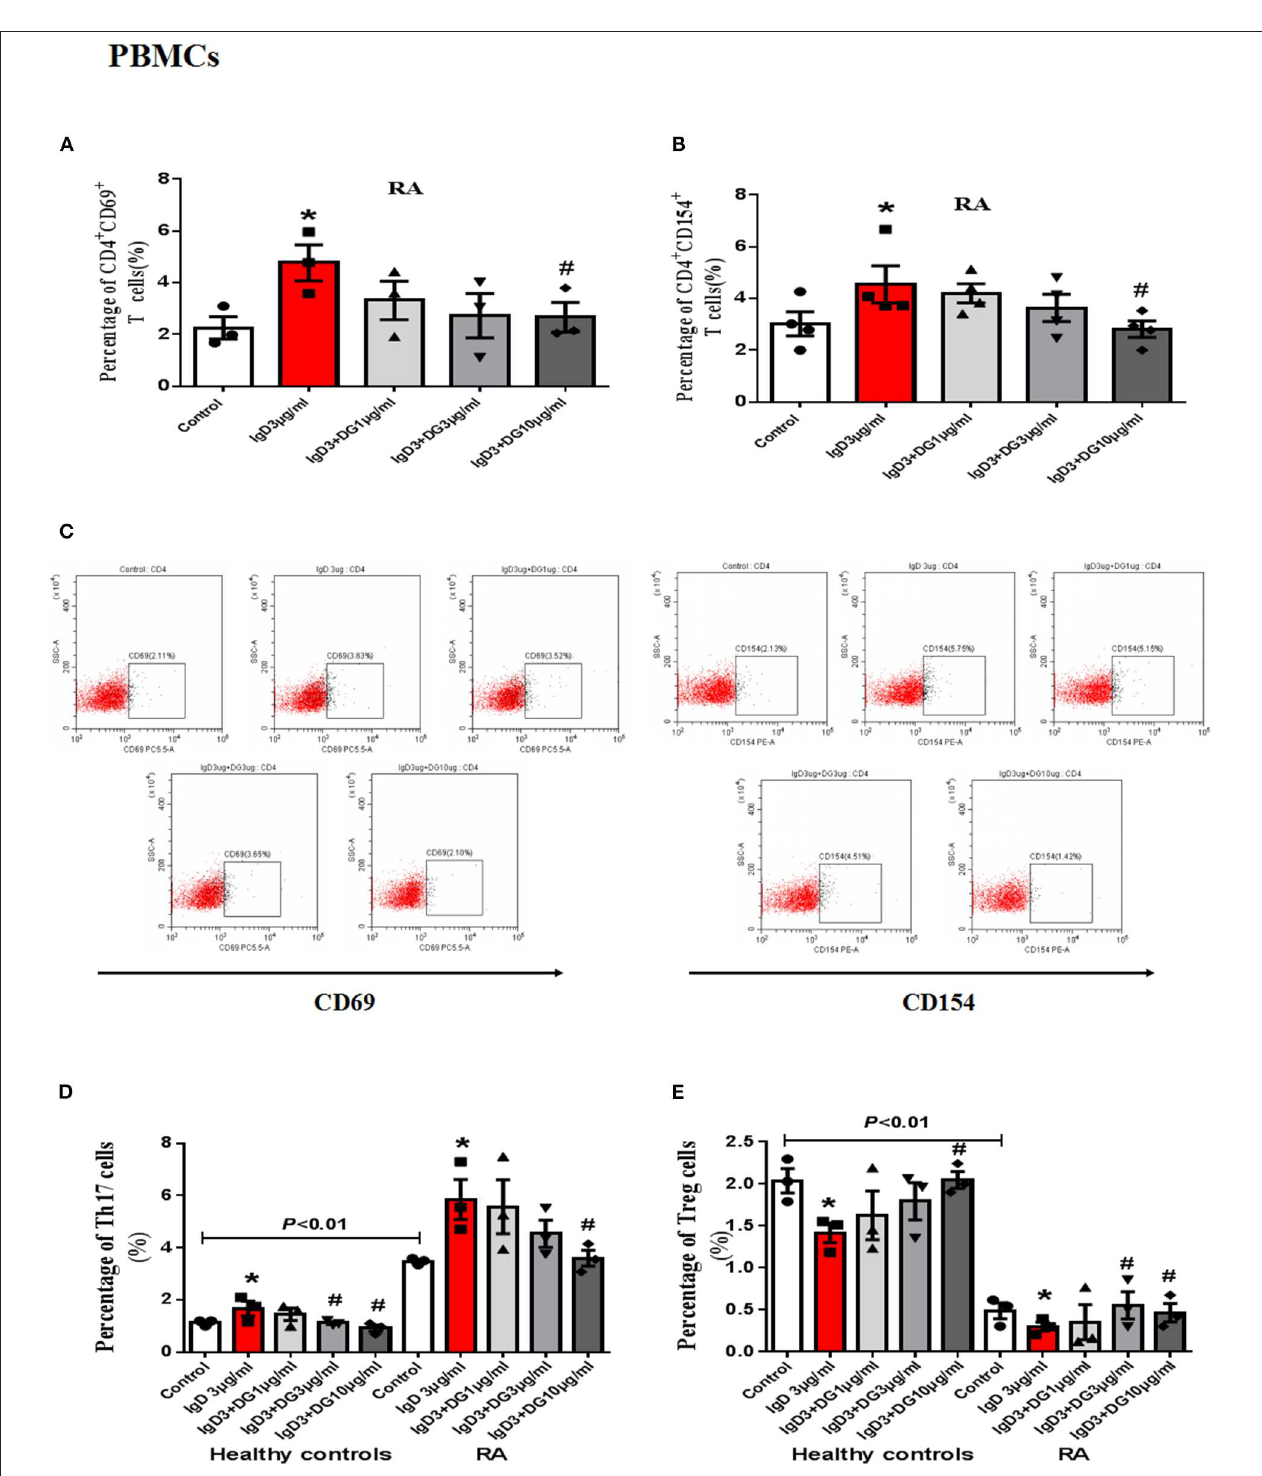
FIGURE 4 | Effects of IgD-Fc-Ig (DG) on the functions of PBMCs induced by IgD. PBMCs of RA patients were incubated with IgD (3 µ g/mL) and different concentrations of IgD-Fc-Ig (1, 3, and 10 µ g/mL) for 48h. Percentage of CD4 + CD69 + and CD4 + CD154 + T cells (A,B) in RA patients treated with IgD-Fc-Ig. (C) The flow cytometry graphs are shown. Percentage of Th17 cells (CD4 + IL17 + T cells) and Treg cells (CD4 + CD25 + FoxP3 + T cells) in RA patients and healthy controls treated with IgD-Fc-Ig (D, E) . Data were expressed as mean ± SEM ( n = 3–5). * P < 0.05 vs. control, # P < 0.05 vs. IgD (3 µ g/mL) group.